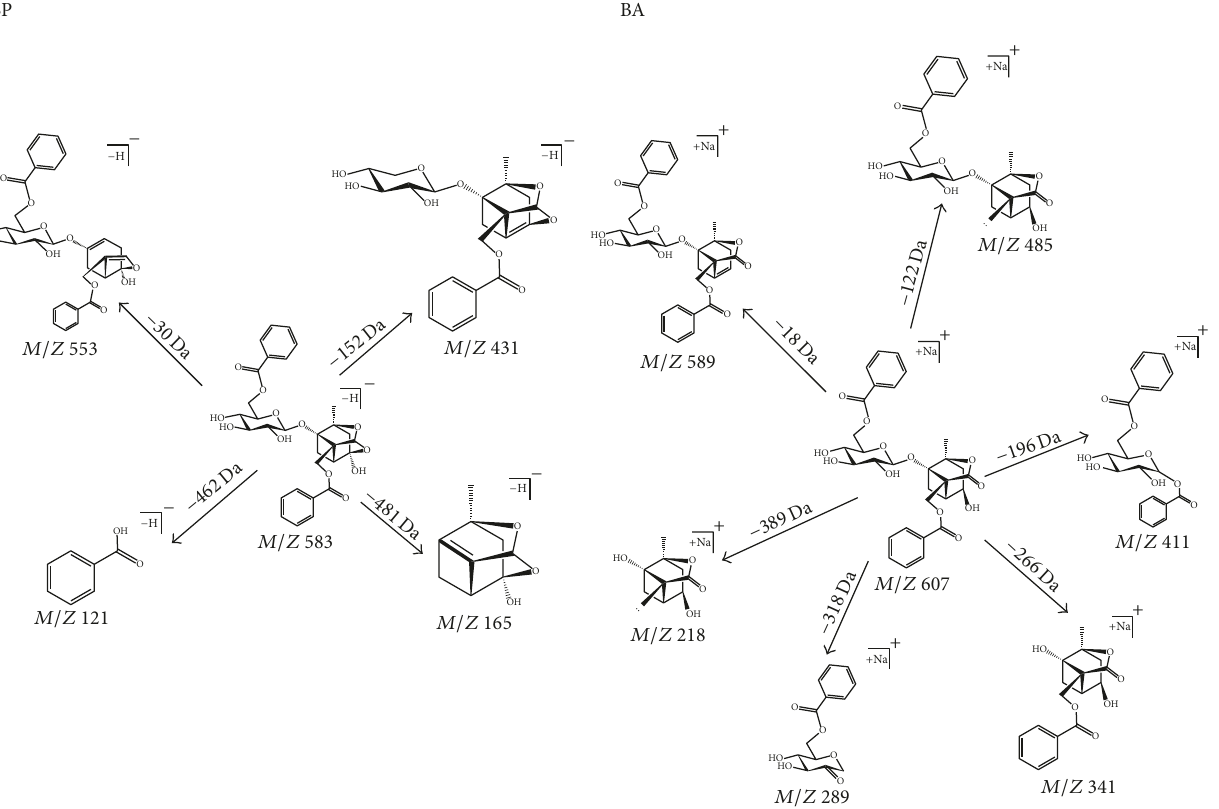
Figure 2: The structure elucidation on BP in negative mode and BA in positive mode.